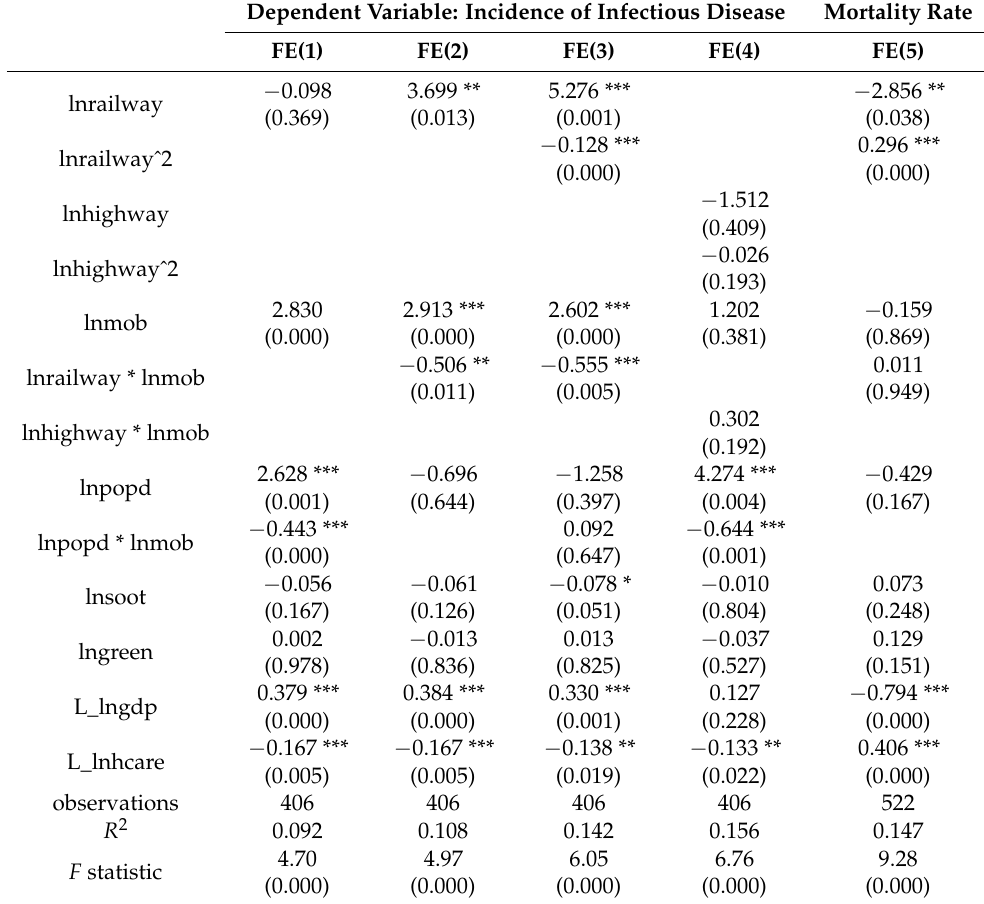
Table 2. Transportation infrastructure, population flow, and the incidence of infectious disease. Dependent Variable: Incidence of Infectious Disease Mortality